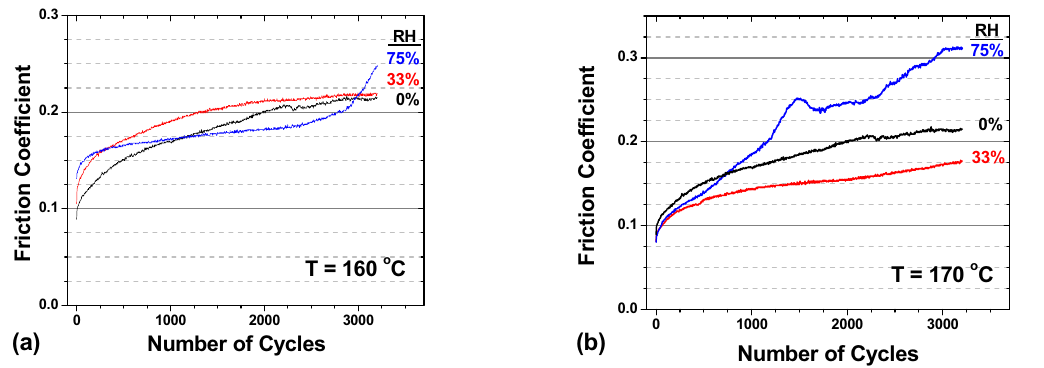
Figure 10: Friction coe ffi cient versus the number of cycles at di ff erent relative humidity for samples made at ( a ) 160°C and ( b ) 170°C. The wear track is perpendicular to the textured lines of the